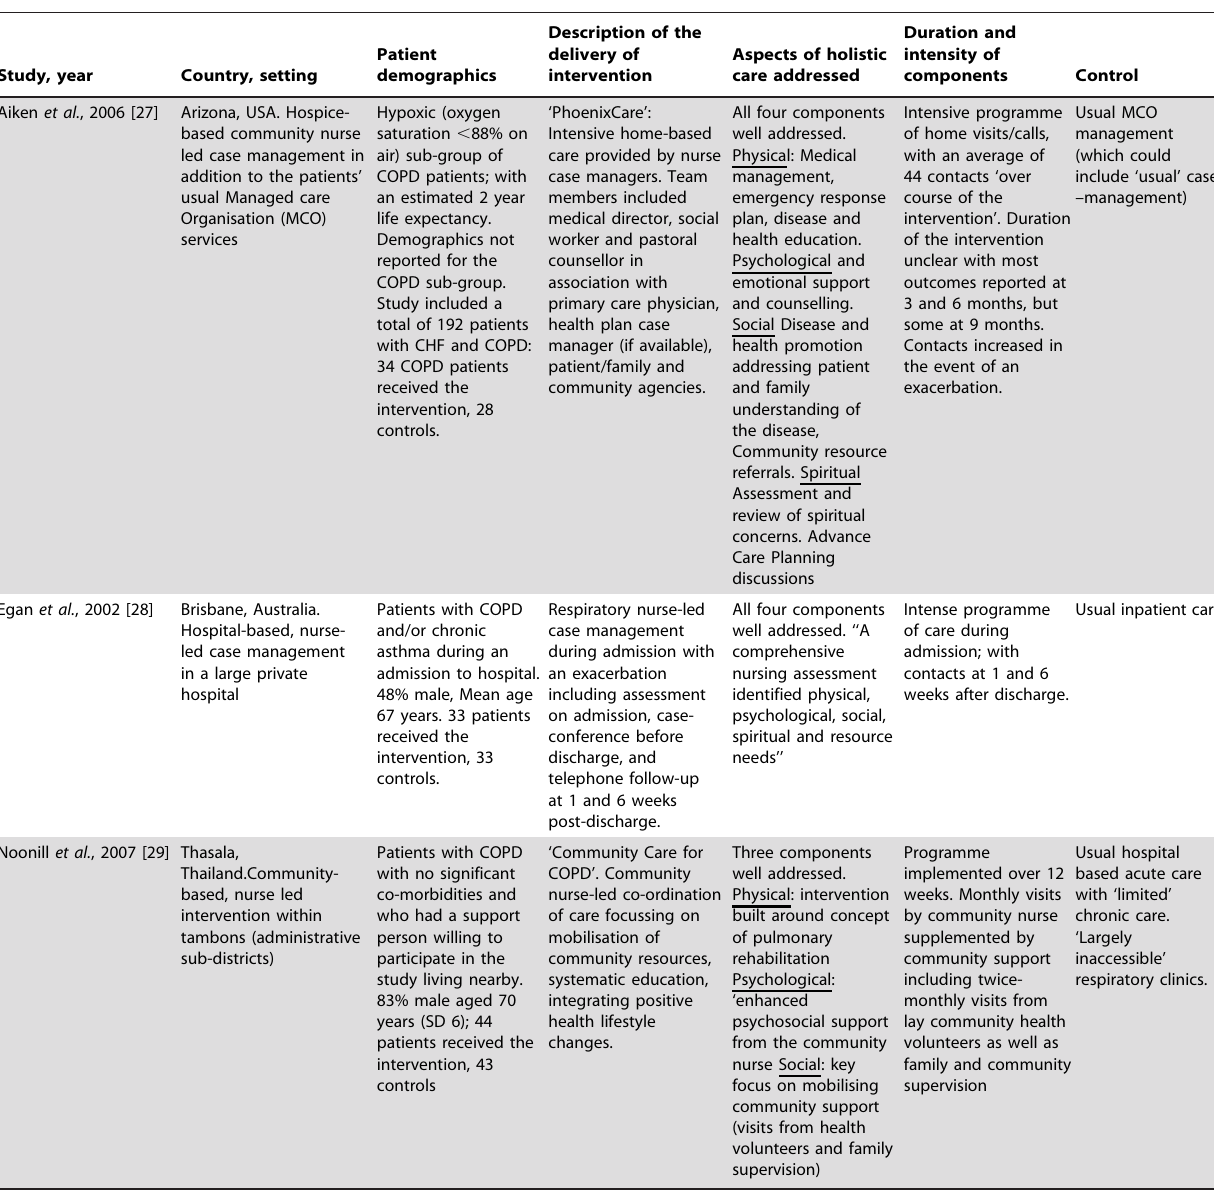
Table 1. Characteristics of included